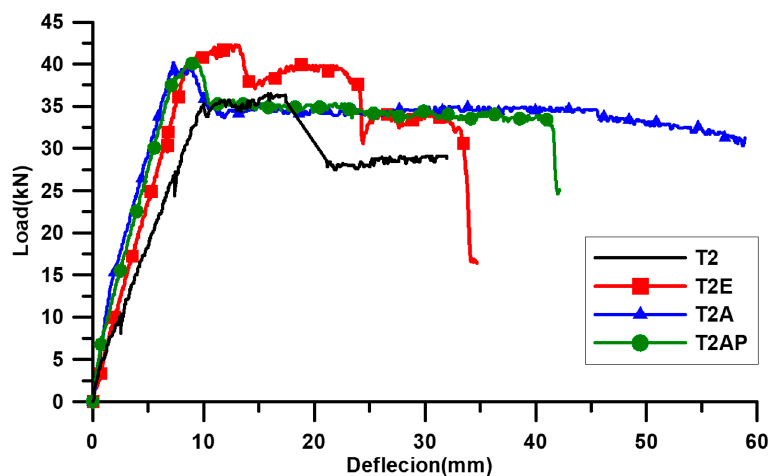
Figure 10. Load and deflection curve: End anchorage.